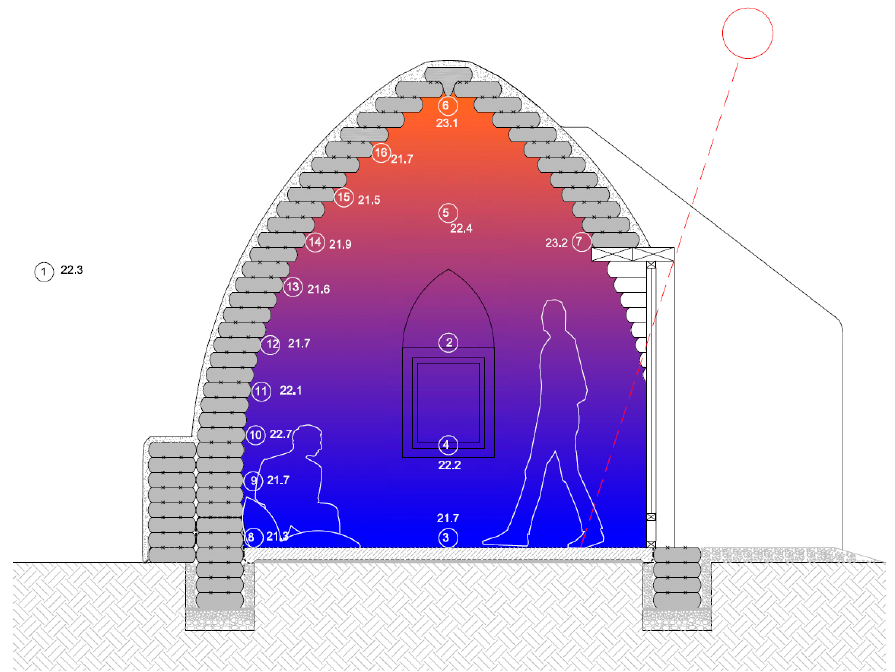
Figure 5. Air stratification inside the Earthbag dome during at solar noon (2 p.m., on 10 June 2018). (Temperature values in °C).